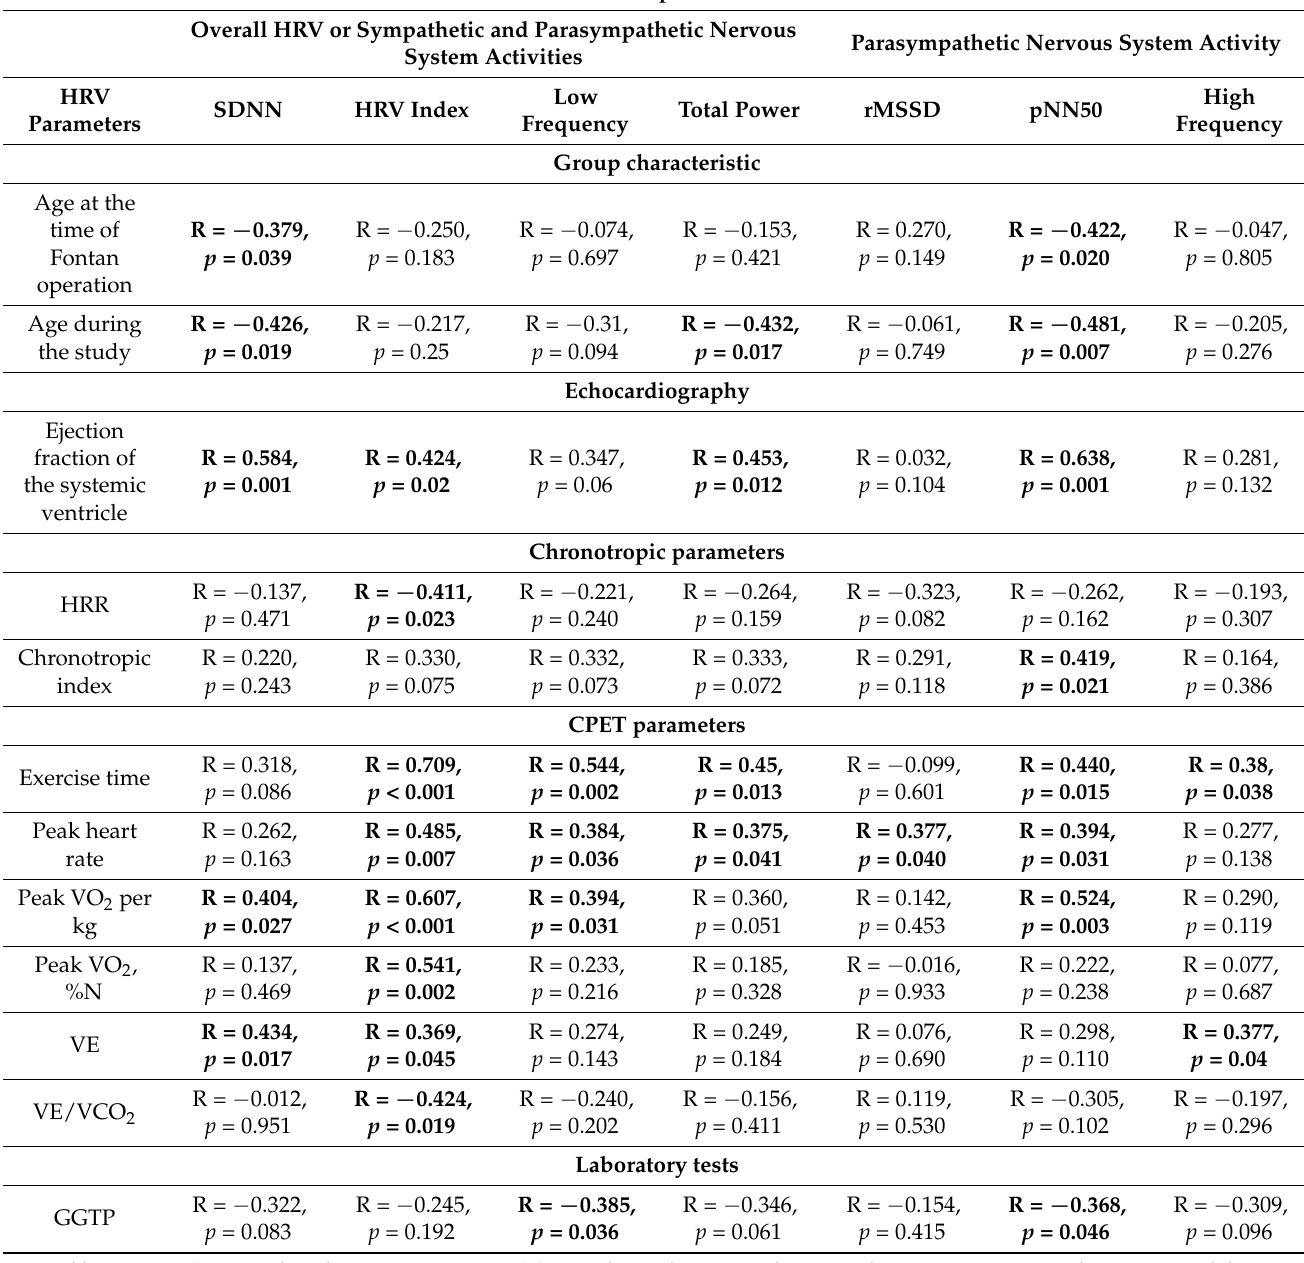
Table 6. Correlations between HRV parameters and patient